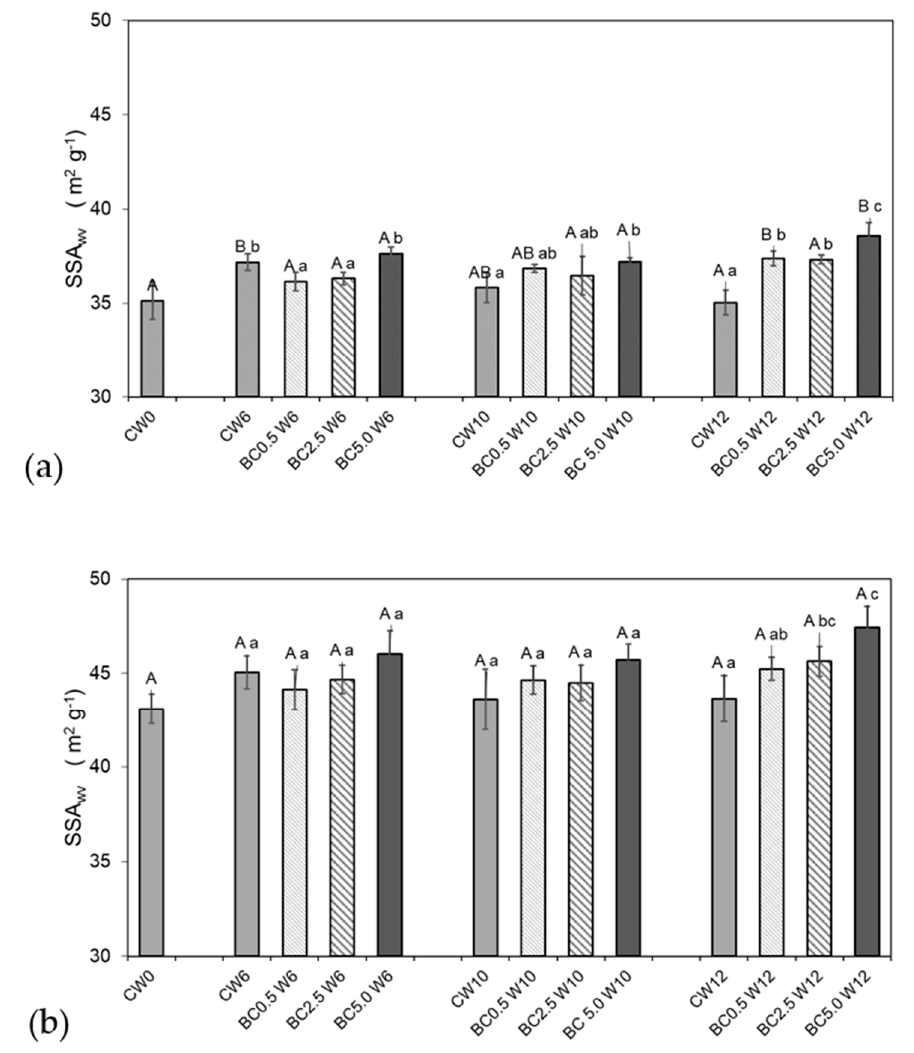
Figure 3. Changes in soil surface area (SSA wv ) over time for the di ff erent treatments, ( a ) adsorption and ( b ) desorption values. C, BC0.5, BC2.5, and BC5.0 represent control, 0.5%, 2.5%, and 5.0% biochar amended soil, respectively. W represents the number of weeks during sampling periods. Means denoted by the same letter did not significantly di ff er at p < 0.05; lowercase letters denote the comparison within biochar treatments, while uppercase letters compare the means of time